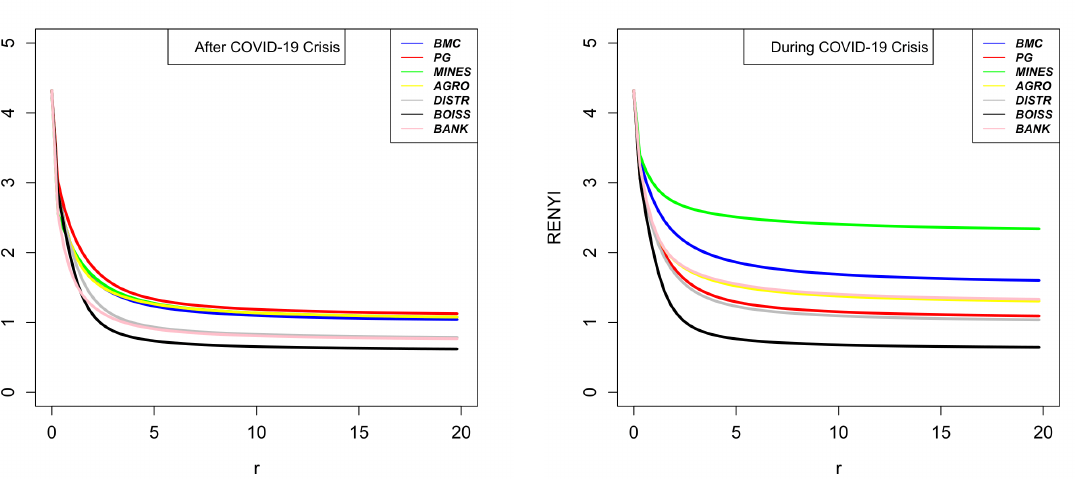
Figure 10. Rényi entropies versus scale r during the crisis period for all